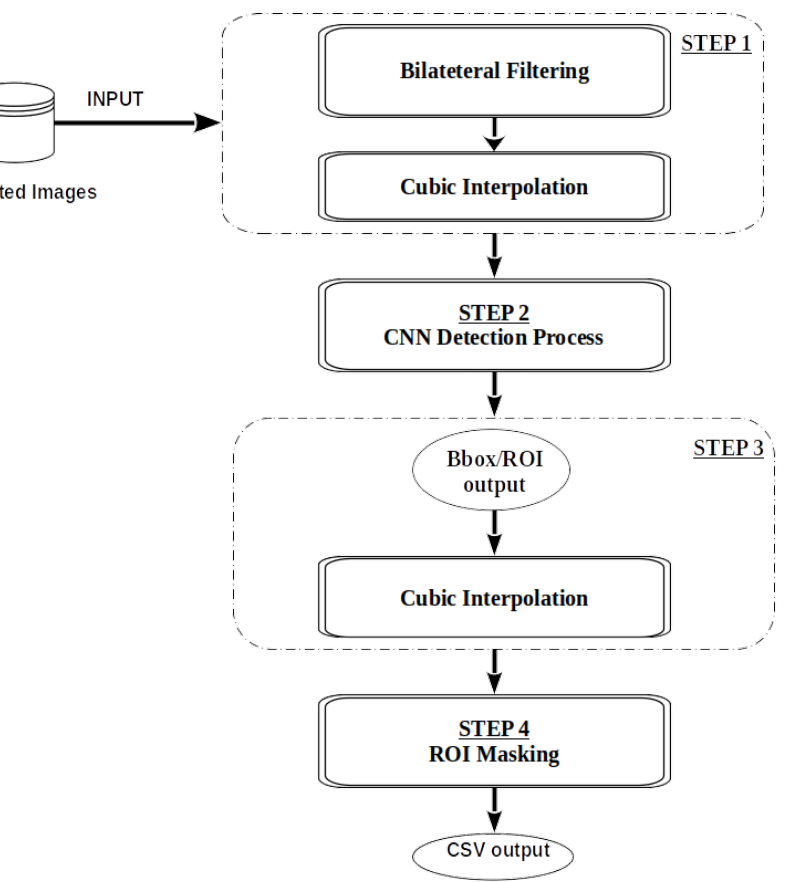
Figure 2. Proposed algorithm process flowchart for the detection of Varroa